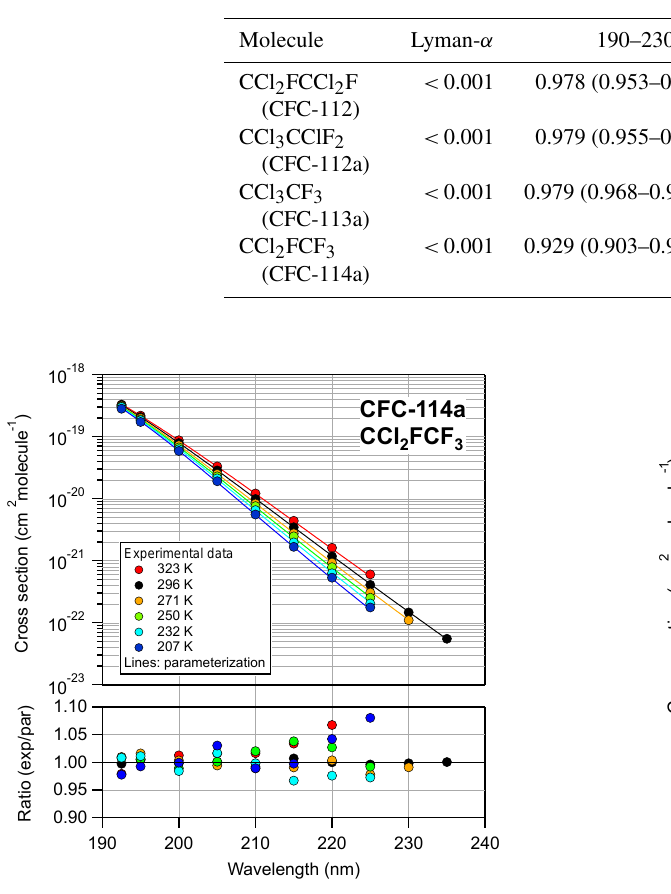
Figure 3. UV absorption spectra (base e) of CFC-112, CFC-112a, CFC-113a, and CFC-114a at 296K calculated using the parameter- ization from this work (Table 3) over the wavelength range of our experimental